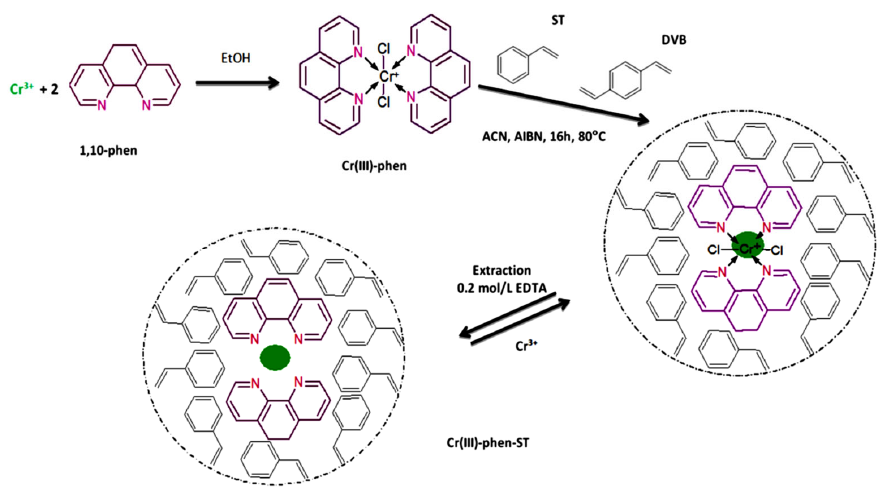
Figure 13. Schematic illustration of the imprinting process for preparation of the Cr(III)-phen-ST-IP (reproduced with permission from Ref. [140]).